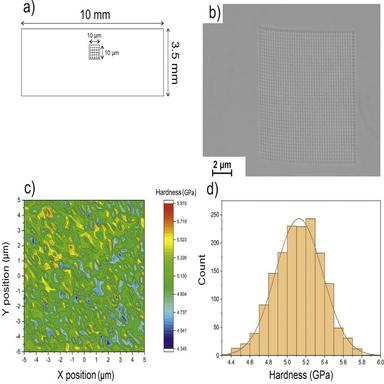
(a) Schematic view revealing the position of the nanoindentation tests in the sample. (b) SEM micrograph of the 1600 indents performed. (c) Nanohardness map of the 10 × 10 μm2 area tested. (d) Histogram revealing a Gaussian distribution in hardness.